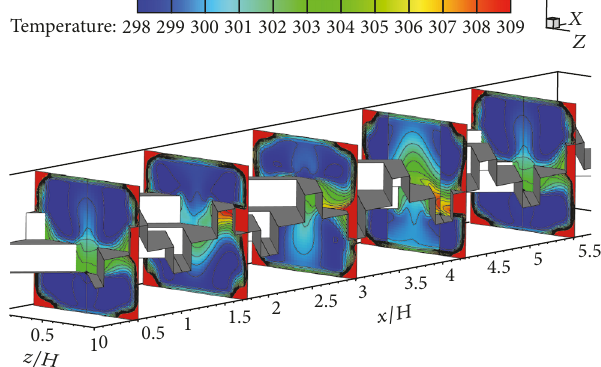
Figure 8: Temperature distribution in transverse planes for the square channel heat exchanger inserted with 45 ∘ wavy plate at Re = 3000 for